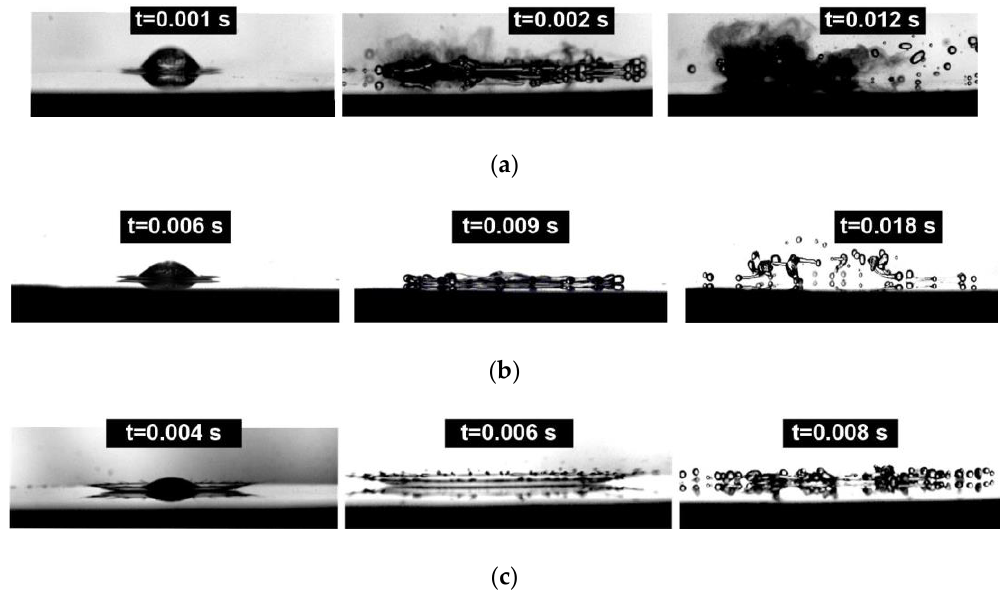
Figure 5. Types of hydrodynamic breakup of WiDME and WiBDME drops: ( a ) breakup by transient boiling with fuming, C-1, T 0 = 300 °C, D 0 = 2.3 mm, U 0 = 3 m/s; ( b ) prompt splash and film boiling breakup, C-3, T 0 = 300 °C, D 0 = 2.25 mm, U 0 = 3 m/s; ( c ) corona splash breakup, C-5, T 0 = 500 °C, D 0 = 2.25 mm, U 0 = 3 m/s.